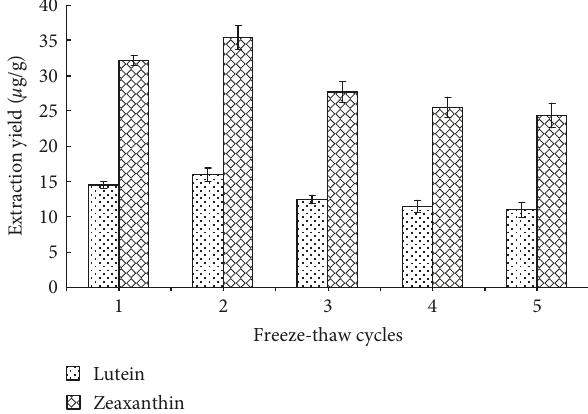
Figure 4: Effect of freeze-thaw cycles on extraction yield of carotenoids.